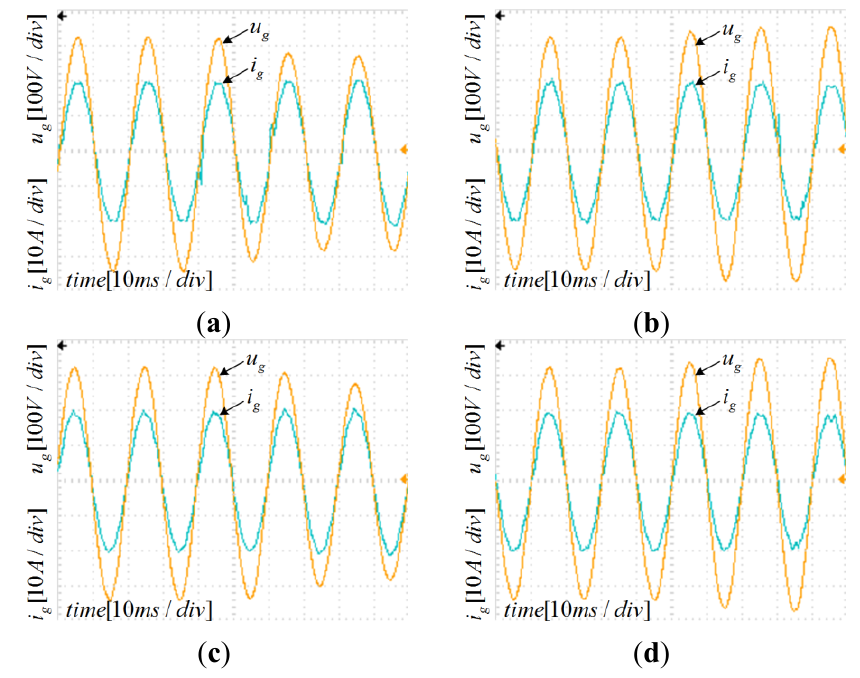
Figure 20. Grid voltage and injected current at full load with inductor L experimental results. ( a ) Inductor L increased by 20%: grid voltage sag; ( b ) inductor L 1 increased by 20%: grid voltage swell; ( c ) inductor L decreased by 20%: grid voltage sag; 1 ( b ) inductor L decreased by 20%: grid voltage swell. 1